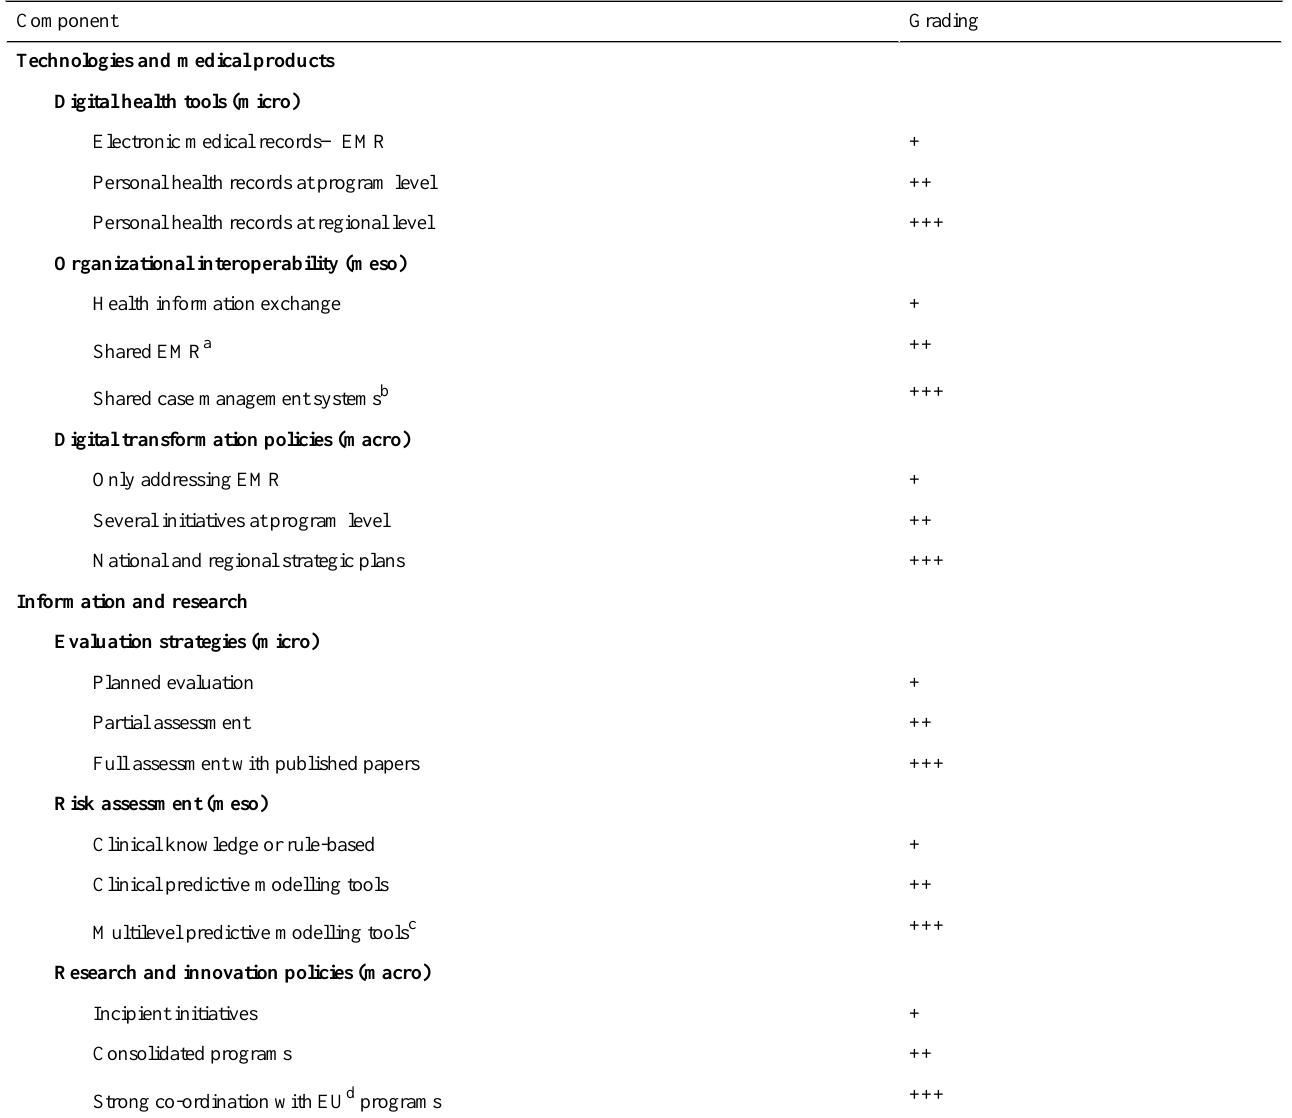
Table 1. Summary of the maturity grading criteria at micro, meso, and macro level for technologies and medical products and for information and